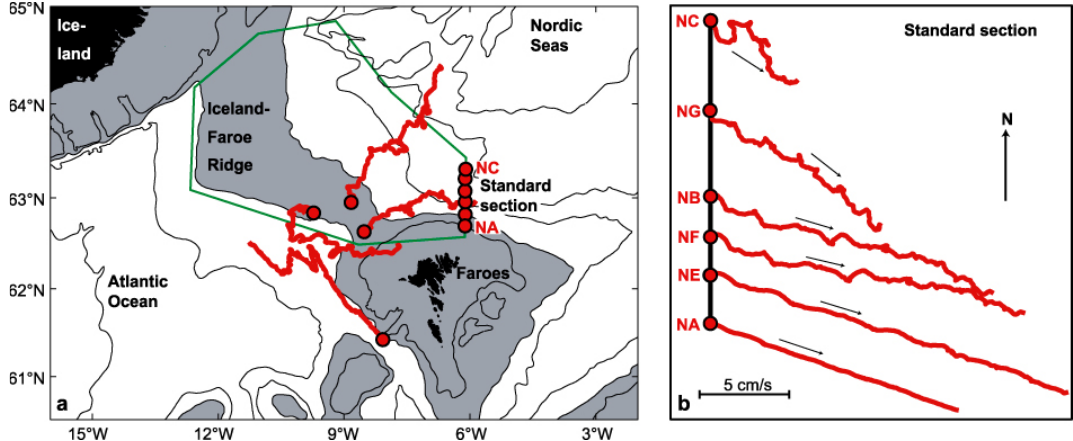
Fig. 5. Progressive vector diagrams for the flow at 225m depth from 4 moored ADCPs (Acoustic Doppler Current Profilers) upstream of or on the IFR (a) and from 6 moored ADCPs on the standard section (b) . The records are from different periods and have different durations between 8 and 12 months. Mooring locations are shown as red circles, from which the progressive vector diagrams extend as red traces. The progressive vector diagrams have been scaled to show the residual velocities in the scale shown on (b) . The region bounded by green lines on (a) was used for calculating the flushing time from upstream to the standard section (Appendix